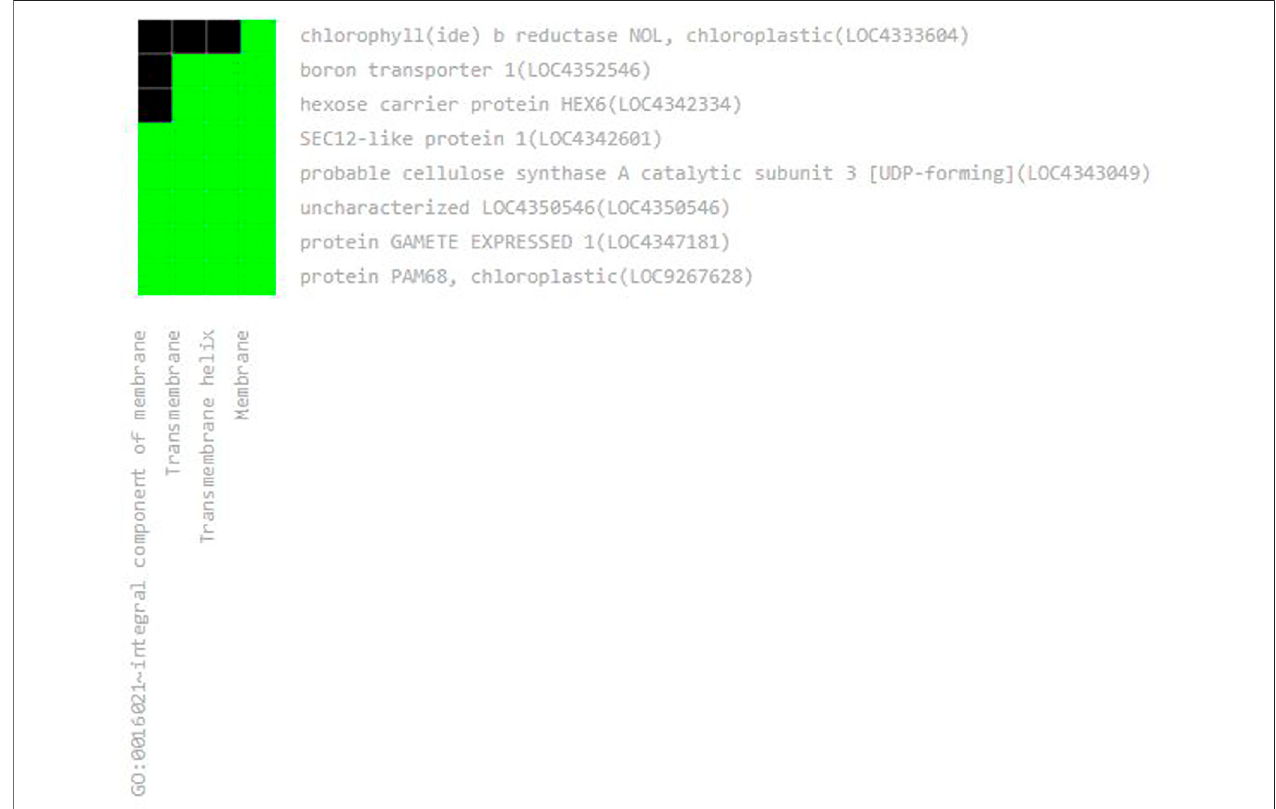
FIGURE 9 | The classi fi cation of identi fi ed hub genes represented by heat map using DAVID software. It is noted that eight genes ( y -axis) are classi fi ed into four classes ( x -axis).